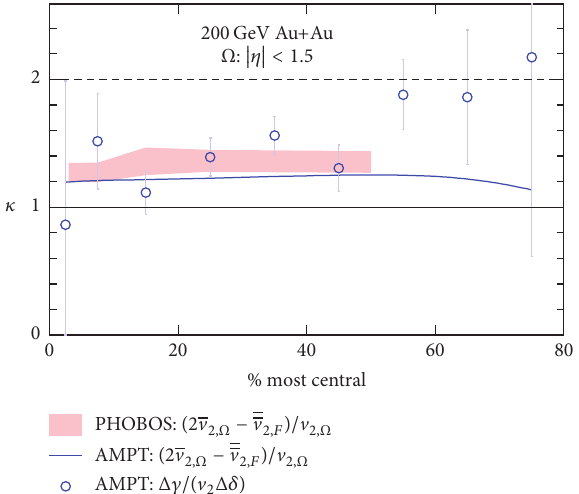
Figure8:Estimationof 𝜅 withthreeapproachesfor200 GeVAu+Au [51].